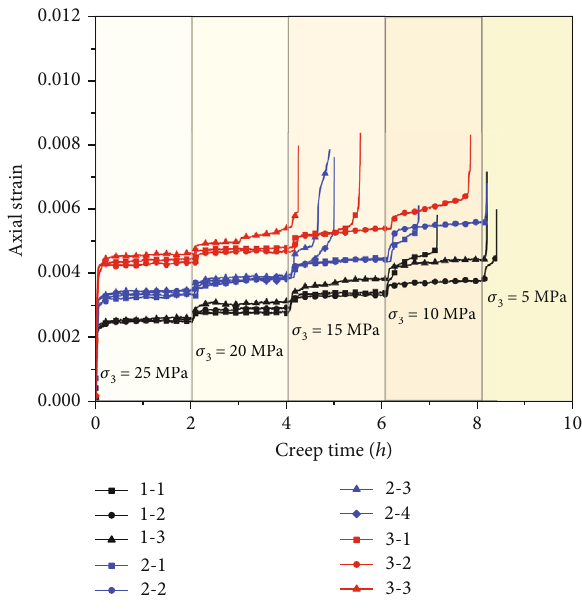
Figure 4: The relationship between axial strain and creep time. Table 1: The grouping of specimens for creep